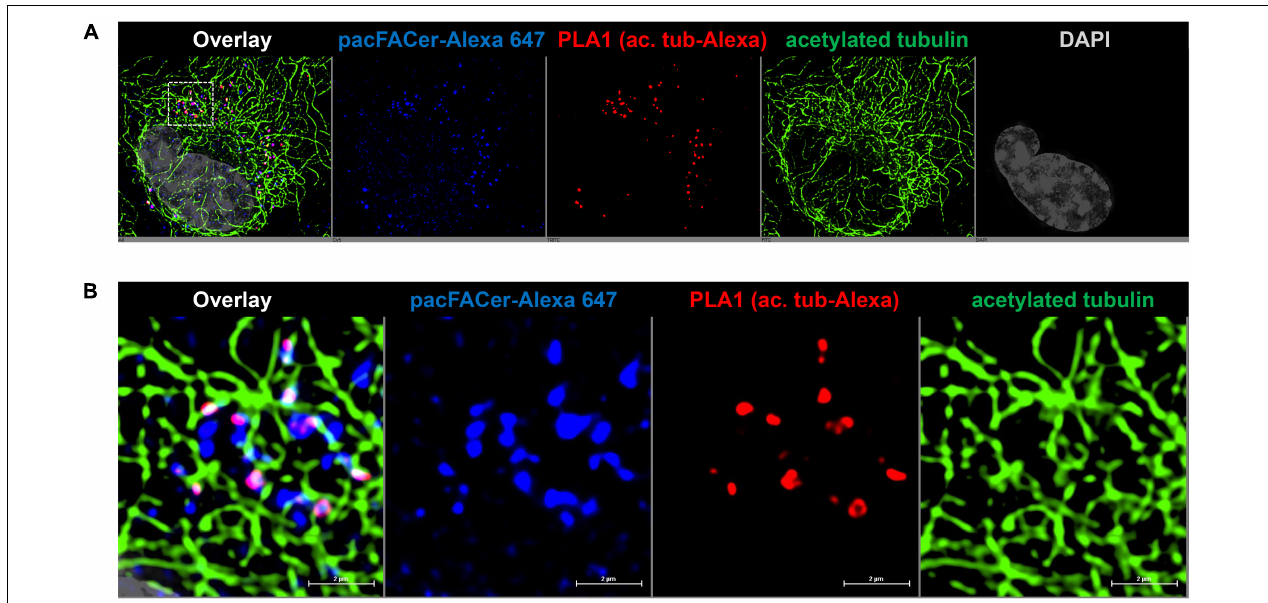
FIGURE 3 | PLA1 reaction using antibodies against acetylated tubulin and Alexa Fluor 647. (A) Primary cultured astrocytes were subjected to the PLA1 reaction (fluorescence signals for complexes of acetylated tubulin with Alexa Fluor 647-pacFACer are pseudo-colored in red) and then post-incubated with Alexa Fluor 488-conjugated secondary antibody to visualize microtubules (pseudo-colored in green). Cross-linked pacFACer (conjugated to Alexa Fluor 647) is pseudo-colored in blue. (B) Detail from (A) shows microtubules with acetylated tubulin cross-linked to pacFACer.